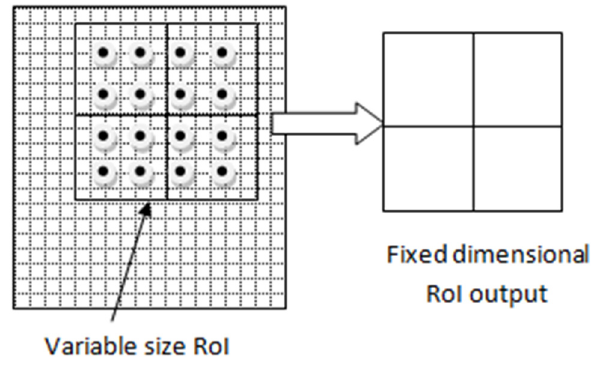
Figure 6. RoI alignment operation.